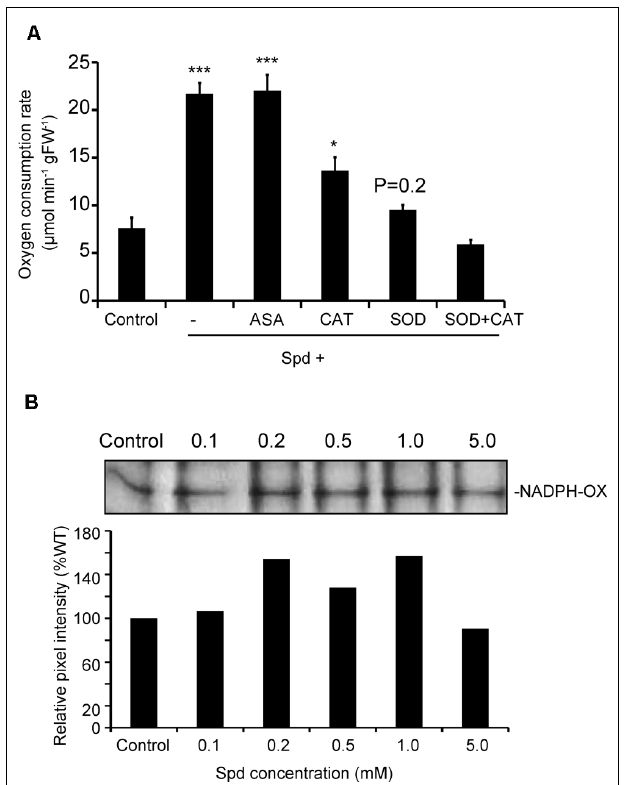
FIGURE 3 | Combined effect of exogenous Spd andASA, CAT or SOD on oxygen consumption rate of Arabidopsis plants and dose-dependent response of NADPH-oxidase activity by Spd. (A) Oxygen consumption rate in plants incubated in the respective medium for 10 min. Data are the means of three independent experiments ± SD. Asterisks indicate statistical significant differences (*** P < 0.001; * P < 0.05). For Spd + SOD treatment P value is indicated. (B) Effect of exogenous Spd on NADPH-oxidase activity in Col-0 Arabidopsis plants. Plants were treated with 0.1, 0.2, 0.5, 1, and 5 mM Spd for a period of 10 min and relative pixel intensity of lane profile after application of 1 mM Spd was